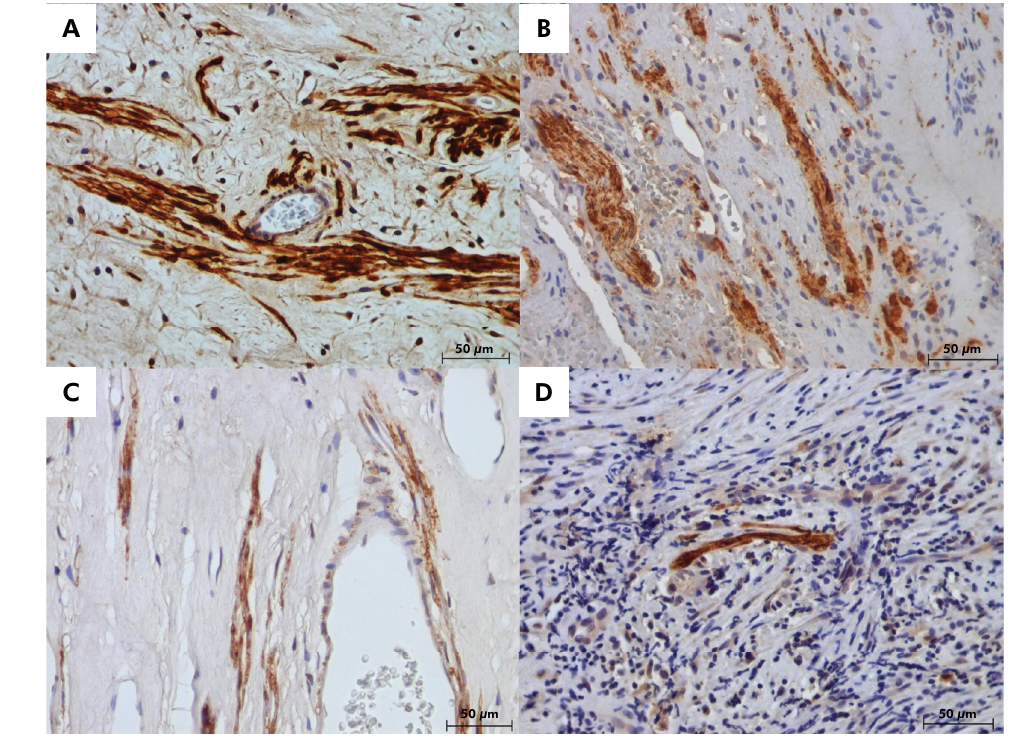
Figure 2. Similar density of S-100 + (A, B) and reduced density of nerve fibers in PGP 9.5 + expression (C, D) in irreversible pulpitis samples (B, D) compared to healthy pulp samples (A, C) (Immunohistochemistry, ×40).